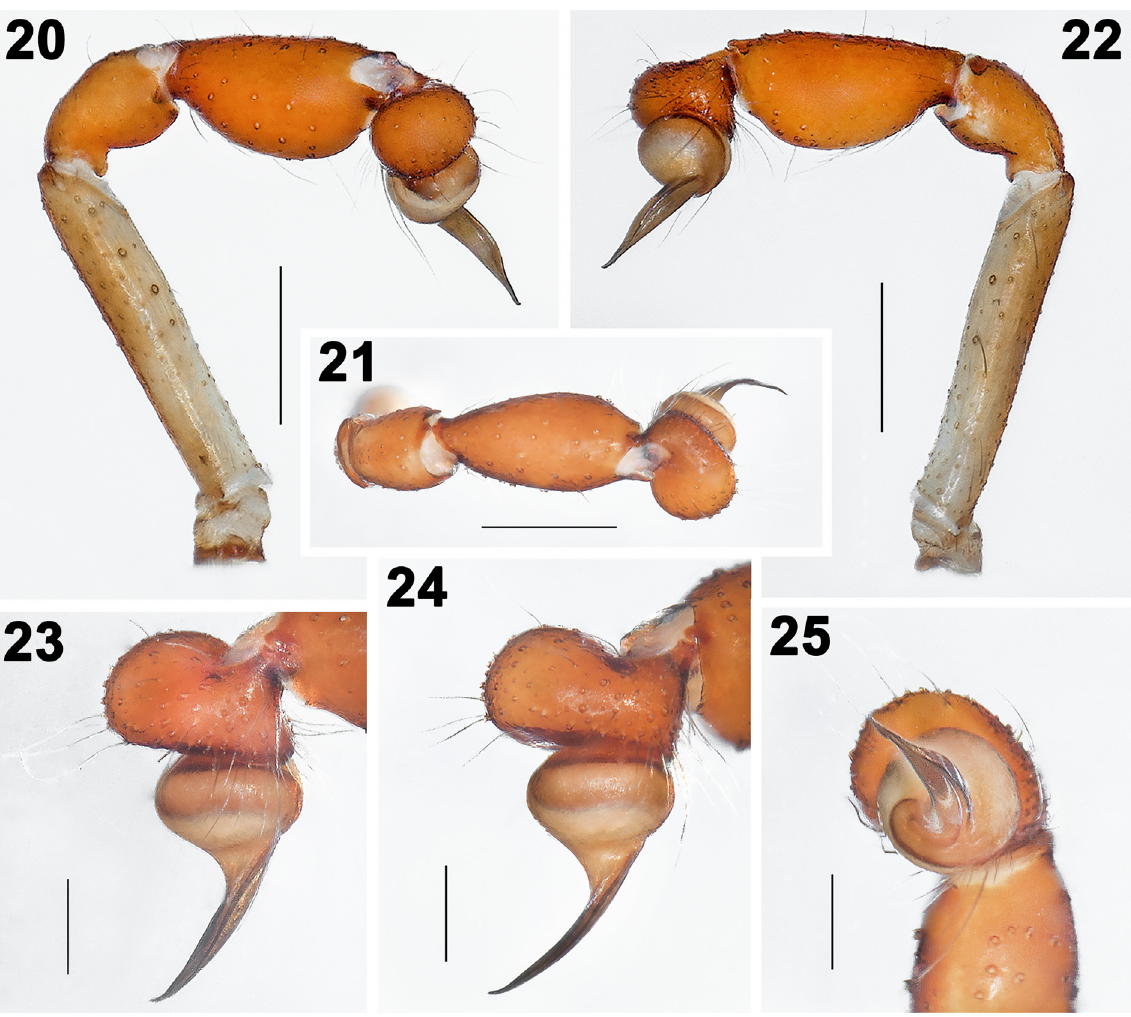
Figs 20–25. Loxosceles tolantongo sp. nov., ♂ holotype (CNAN-T01317). 20–22 . Left palp, prolateral, dorsal and ret rolateral views, respectively. 23–25 . Detail of the bulb and embolus, retrolateral, dorsal and apical views, respectively. Scale bars: 20–22 = 0.5 mm; 23–25 = 0.2